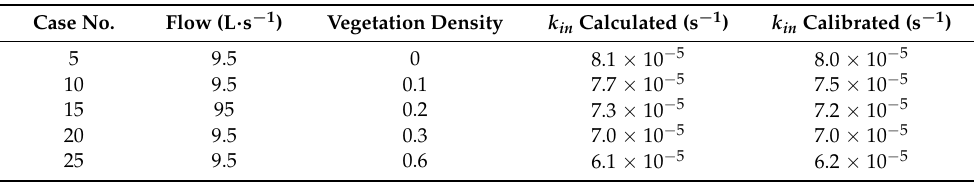
Figure 4. Relationships between the inner dissipation coefficient and various parameters. Table 3. Comparison of the inner dissipation coefficient of supersaturated total dissolved gasbetween calculated results and experimental data. Case No.